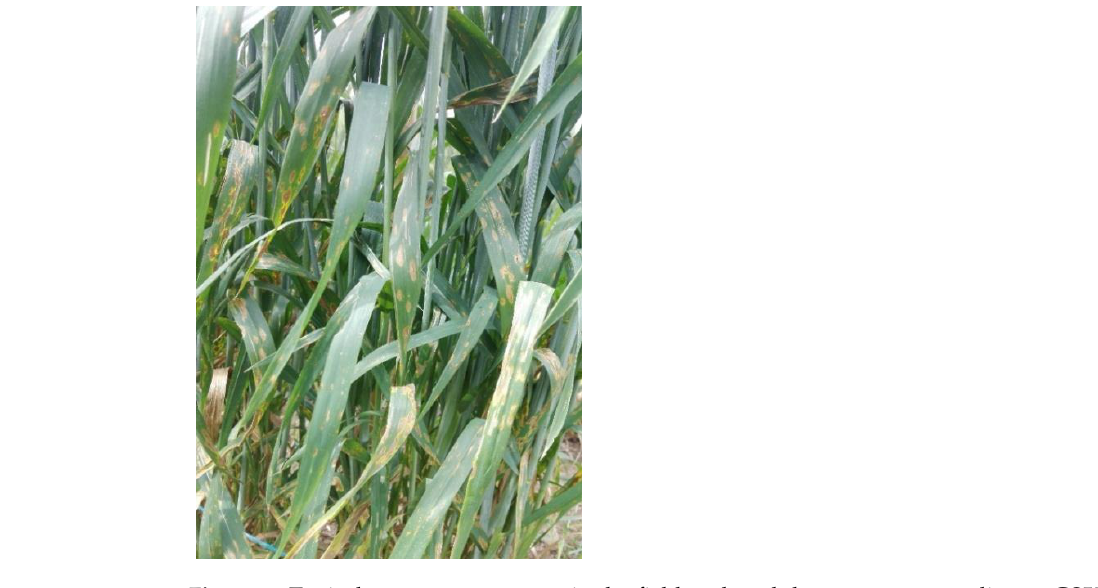
Figure 2. Typical tan spot symptoms in the field at the adult stage corresponding to GS55 at the Septoria Precision Phenotyping Platform (Experimental station of Koudia, Bou Salem, Tunisia).